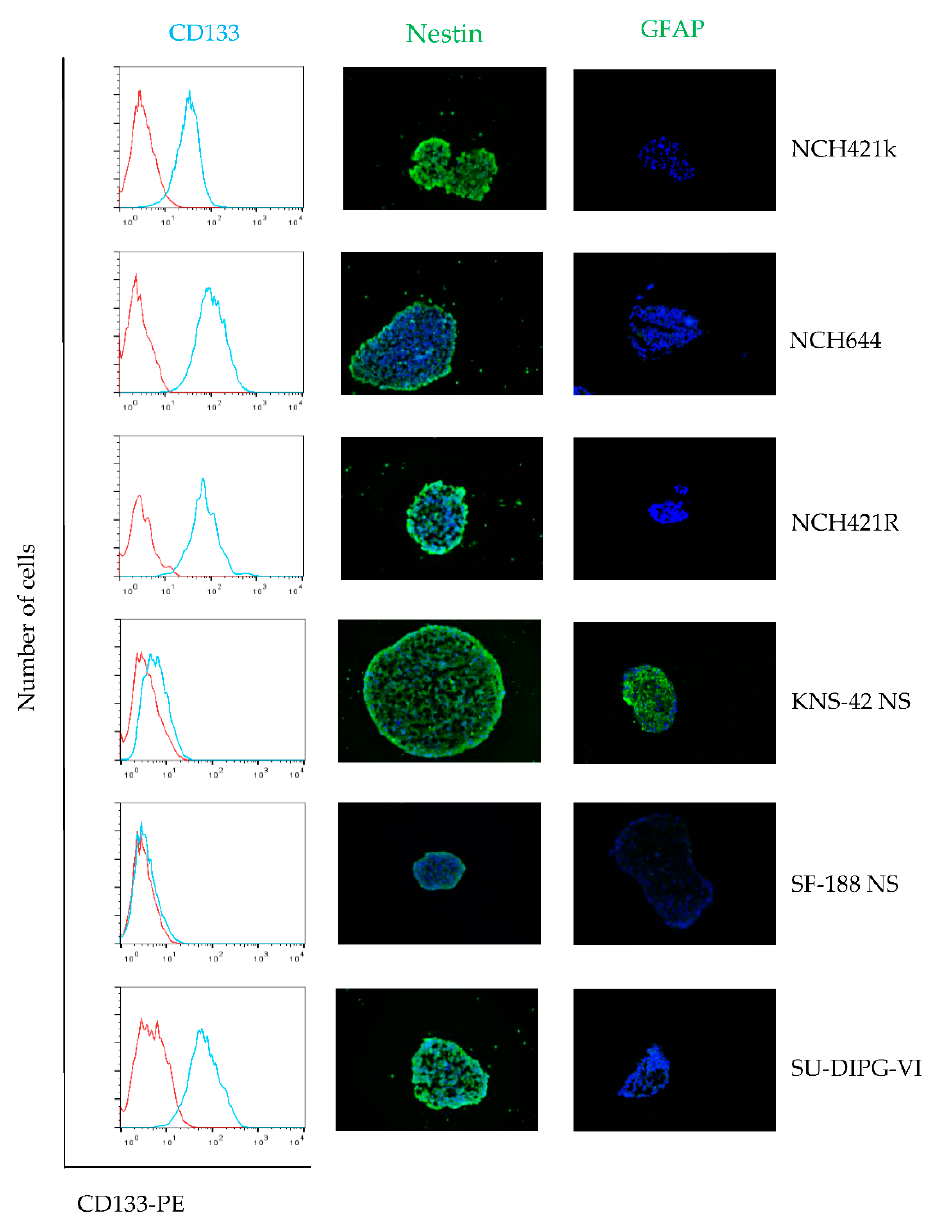
Figure 1. High-grade glioma (HGG) neurosphere cultures show stem cell features . Expression of neuroepithelial stem cell marker proteins CD133 and Nestin, and the astrocyte lineage marker glial fibrillary acidic protein (GFAP) in neurosphere cultures were determined by fluorescence-activated cell sorting (FACS) analysis and immunofluorescence microscopy. CD133 expression was assayed by FACS ( cyan ) and isotype control is depicted as the ( red ) respectively. Immunofluorescence for Nestin ( green ) and GFAP ( green ) merged with Hoechst 33342 ( blue ), magnification 400 ×.